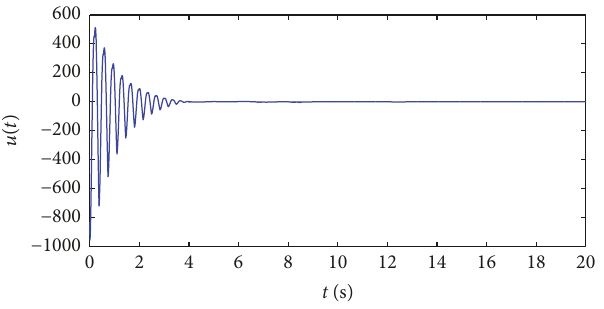
Figure 10: The controller 𝑢(𝑡) response with time 𝑡